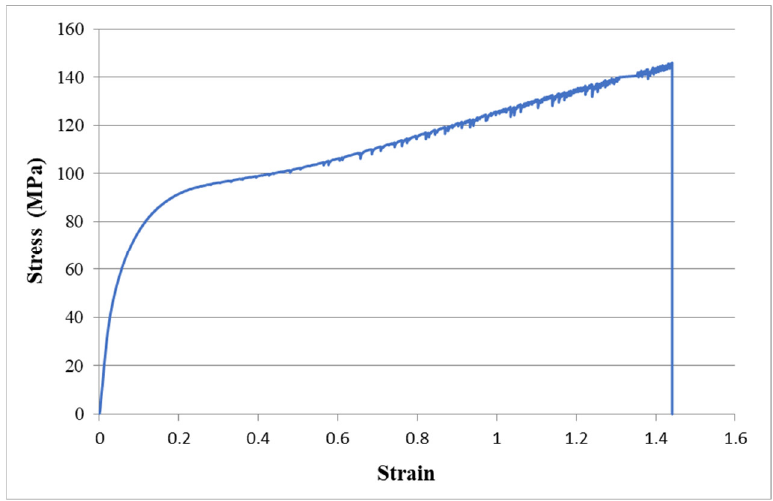
Table 1. Tensile properties of the PI substrate.